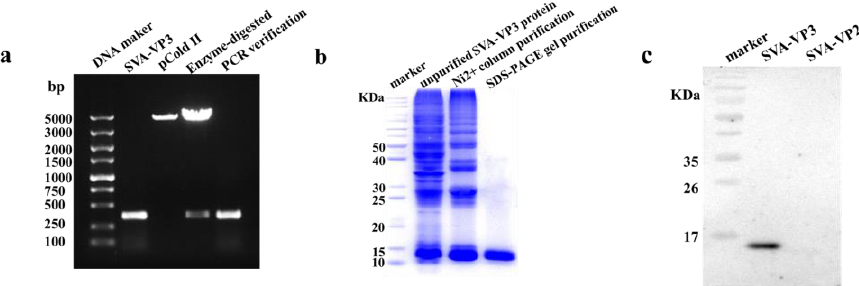
Figure 1. Expression and purification of recombinant SVA-VP3 protein. ( a ) The SVA-VP3 gene was amplified by RT-PCR and inserted into a pColdII vector. The pColdII-SVA-VP3 was identified by restriction enzyme digestion and PCR. ( b ) Recombinant SVA-VP3 protein was purified through Ni 2+ column affinity chromatography and SDS-PAGE gel purification. All protein samples were analyzed by SDS-PAGE. ( c ) The recombinant SVA-VP3 protein was identified by Western blotting using an anti-His-tag antibody. Recombinant SVA-VP2 protein was used as a negative control.